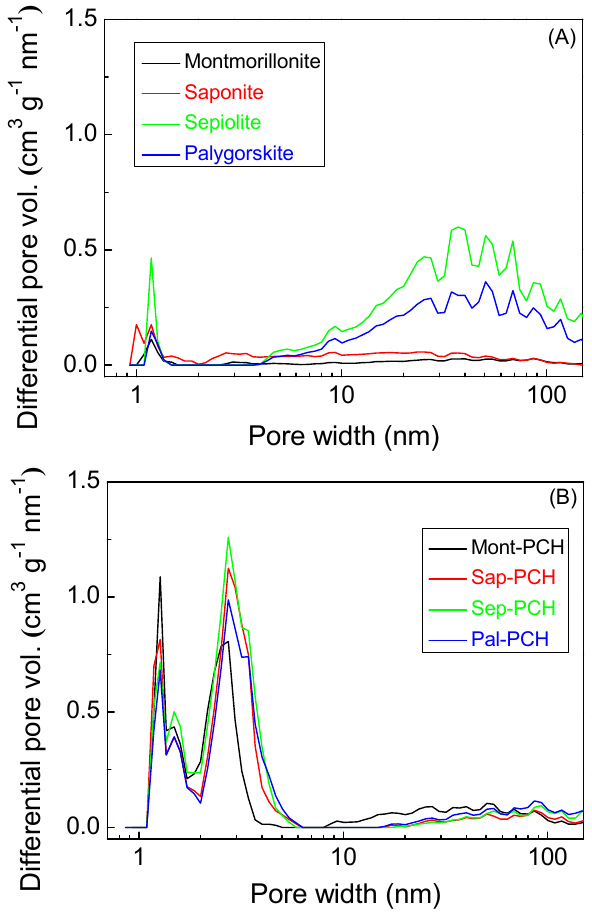
Figure 8. Pore size distribution, estimated by the Density functional theory (DFT) method of the raw montmorillonite, saponite, sepiolite and palygorskite ( A ) and their respective PCHs ( B ).